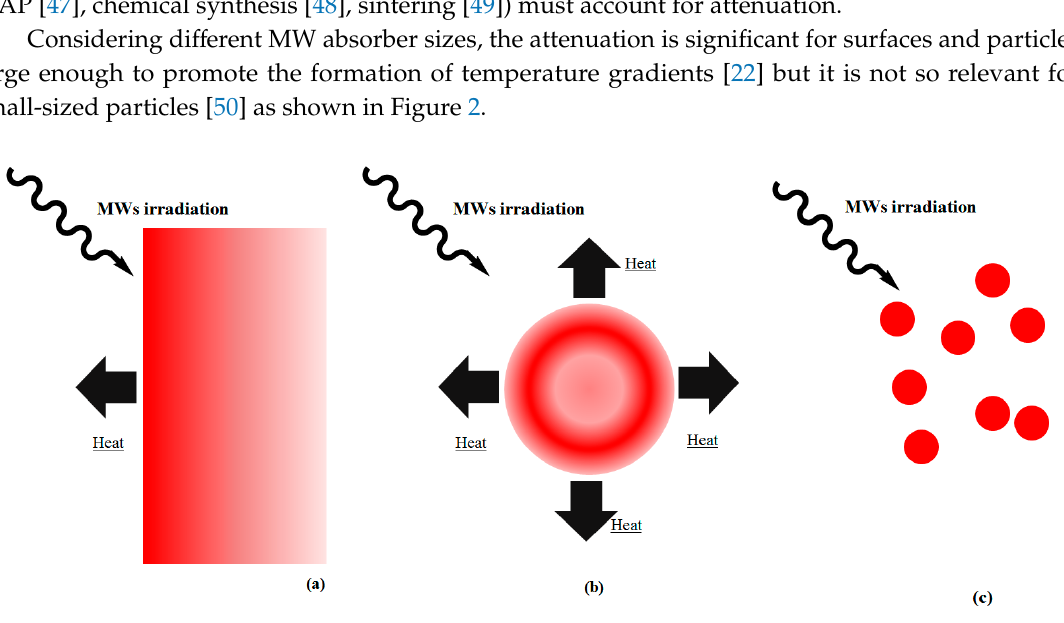
Table 1. Summary of common temperature measurement instruments used during pyrolysis with their limitation for microwave assisted pyrolysis (MAP) monitoring.